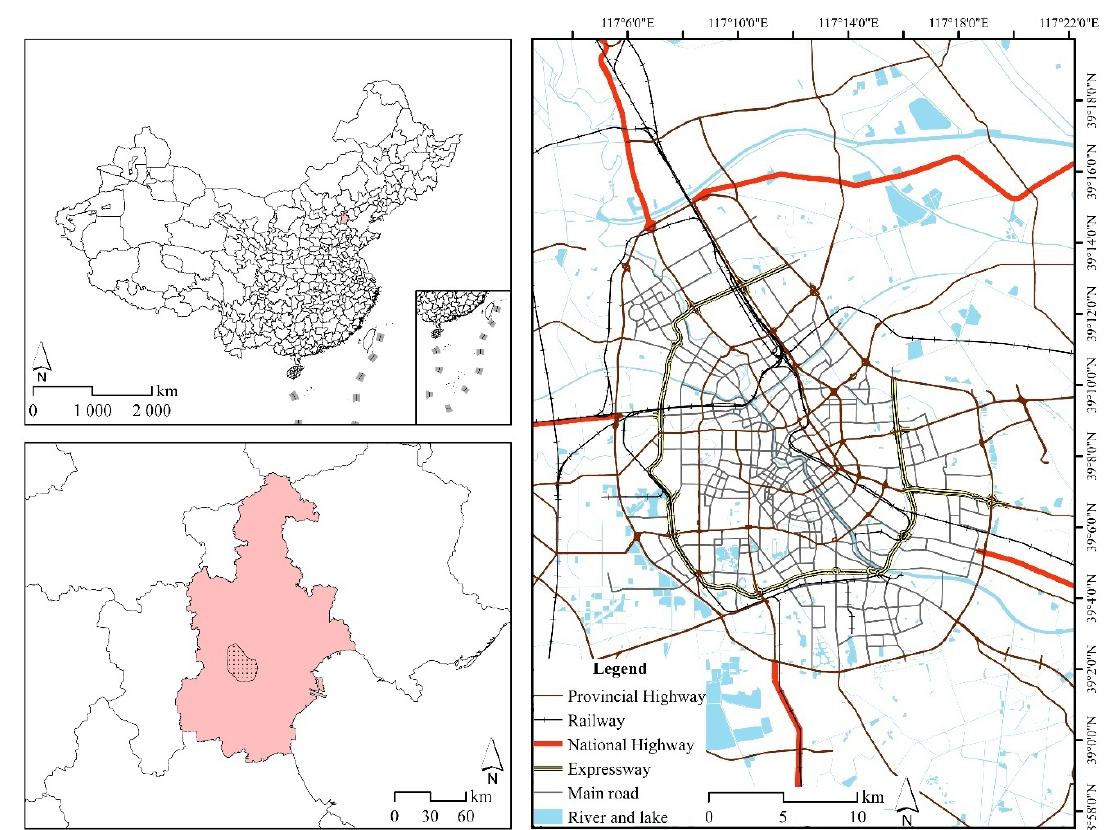
Figure 1. Study area.